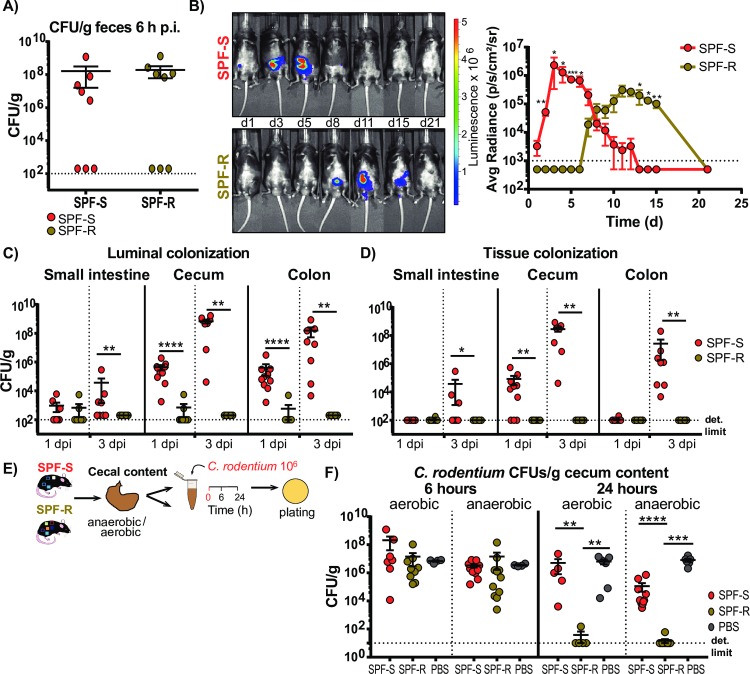
Delayed colonization in SPF-R mice is visible in all intestinal organs and tissues but most prominent in the cecum.(A) SPF-S and SPF-R mice were infected orally with 108 CFU C. rodentium and fecal colonization was determined after 6 hours post infection (p.i.). (B) SPF-S and SPF-R mice were infected orally with 108 CFU C. rodentium and infection was imaged in vivo using an IVIS imaging system. Average radiance (p/s/cm3/sr) was determined at day 1, 3, 5, 8, 11, 15 and 21 p.i. (C-D) SPF-S and SPF-R mice were infected orally with 108 CFU C. rodentium and sacrificed after 1 day or 3 days p.i. CFU/g organ content and tissue was determined. Dashed lines indicate the limit of detection. Results represent two independent experiment with n = 5–7 mice/group as mean ± SEM. P values indicated represent a nonparametric Kruskal-Wallis test *p<0.05, **p<0.01, ***p<0.001, ****p<0.0001. (E) Isolated cecal content of SPF-S and SPF-R mice was diluted 1:1 in PBS, inoculated with 106 CFU C. rodentium and cultivated under aerobic and anaerobic conditions for 24 h before plating on selective agar plates. (E-F) Recovery of C. rodentium in isolated cecal content after 6 and 24 h of aerobic and anaerobic cultivation. Dashed lines indicate the limit of detection. Results represent one or two independent experiments with n = 5–7 mice/group as mean ± SEM. P values indicated represent a Mann-Whitney U test comparison between groups with **p<0.01, ***p<0.001, ****p<0.0001.